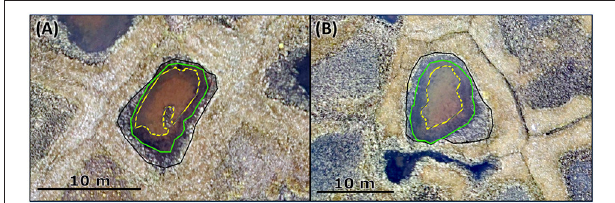
FIGURE 3 | Excerpt of the orthophoto ( Figure 2D ) shows two exemplary polygonal-center ponds, panel (A) shows pond 3, panel (B) shows pond 21. Both are located on Samoylov Island. The black line marks the edge of the pond, the green line delimits the overgrown area, and the yellow dashed line marks the moss-covered parts of the